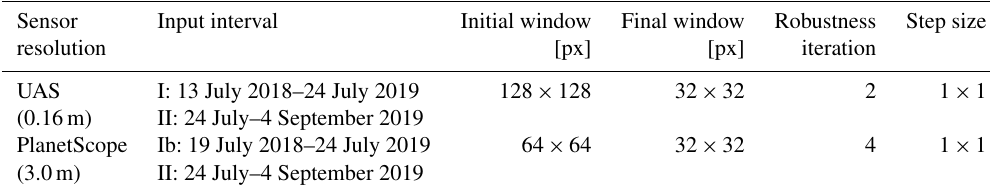
Table 6. COSI-Corr input parameters for intervals of the UAS and PlanetScope.